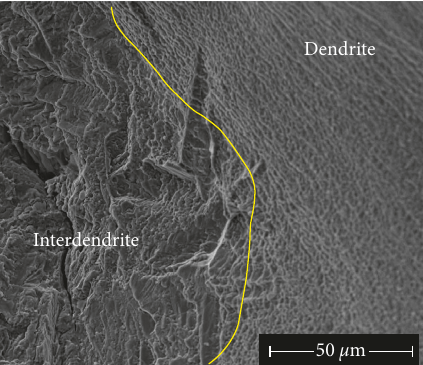
Figure 6: Fracture surface of cast alloy after tensile tests at a temperature of 800 °